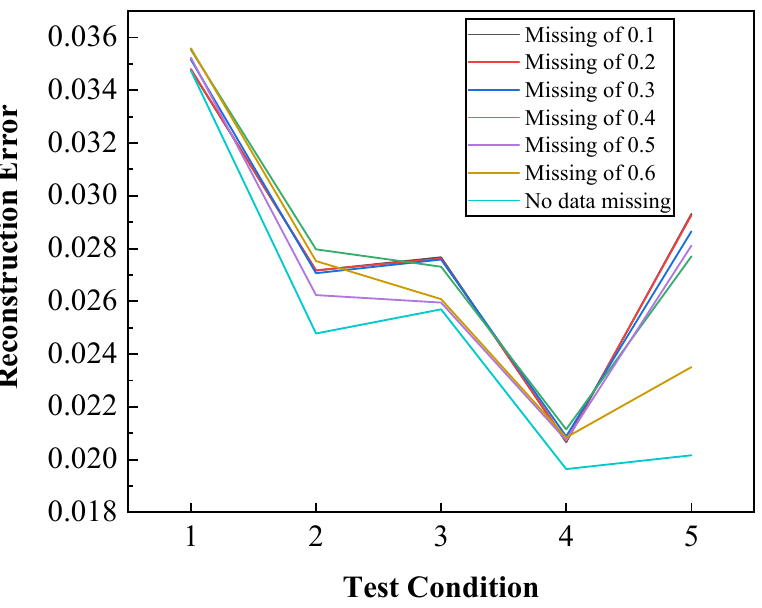
Figure 6. Reconstruction errors of different missing ratios.